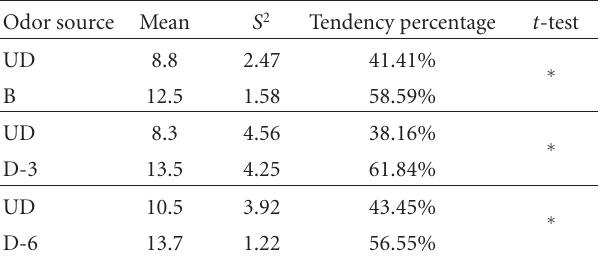
Table 2: The tropic response of C. sinica to Japanese wax scale and damaged persimmon leaves without wax